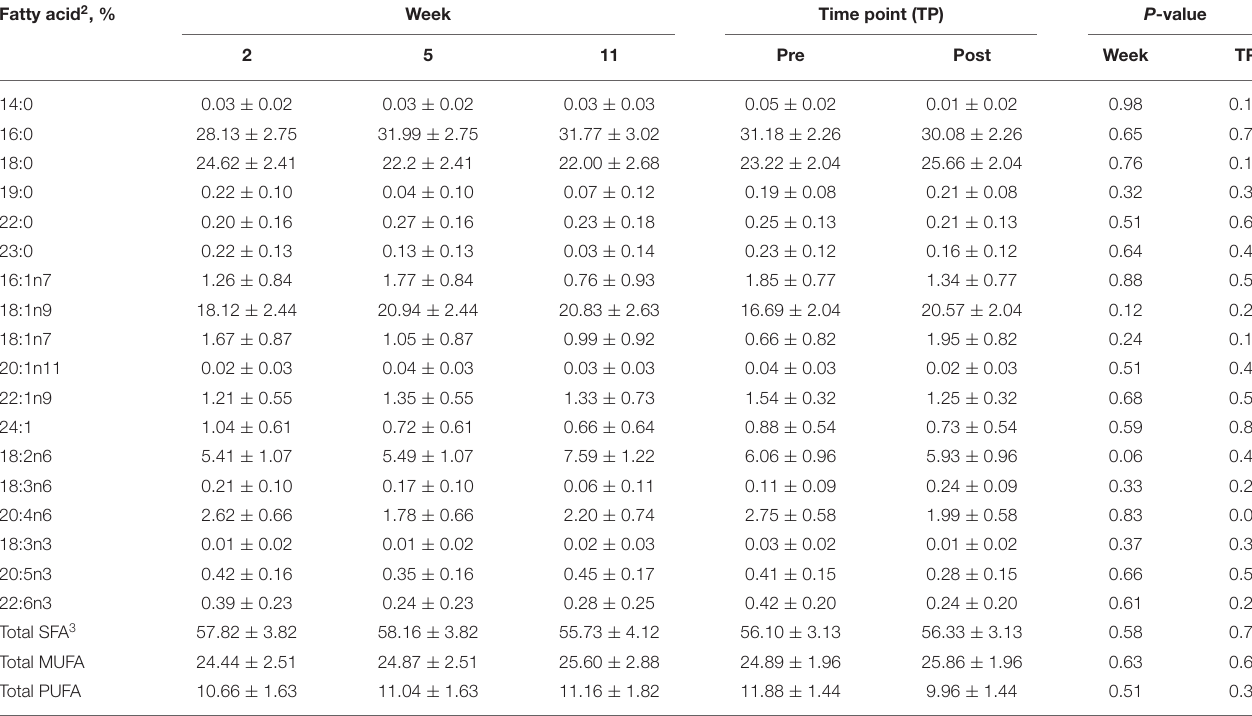
TABLE 3 | Mean fatty acid composition ( ± SE 1 ) and percent contribution of saturated fatty acids (SFA), monounsaturated fatty acids (MUFA), and polyunsaturated fatty acids (PUFA) for the diacylglycerol (DAG) fraction identified in serum of all dogs at weeks 2, 5, and 11 (pooled across pre- and post-exercise sampling time points) and at the pre- and post-exercise sampling time points (pooled across weeks 2, 5, and 11). Fatty acid 2 ,